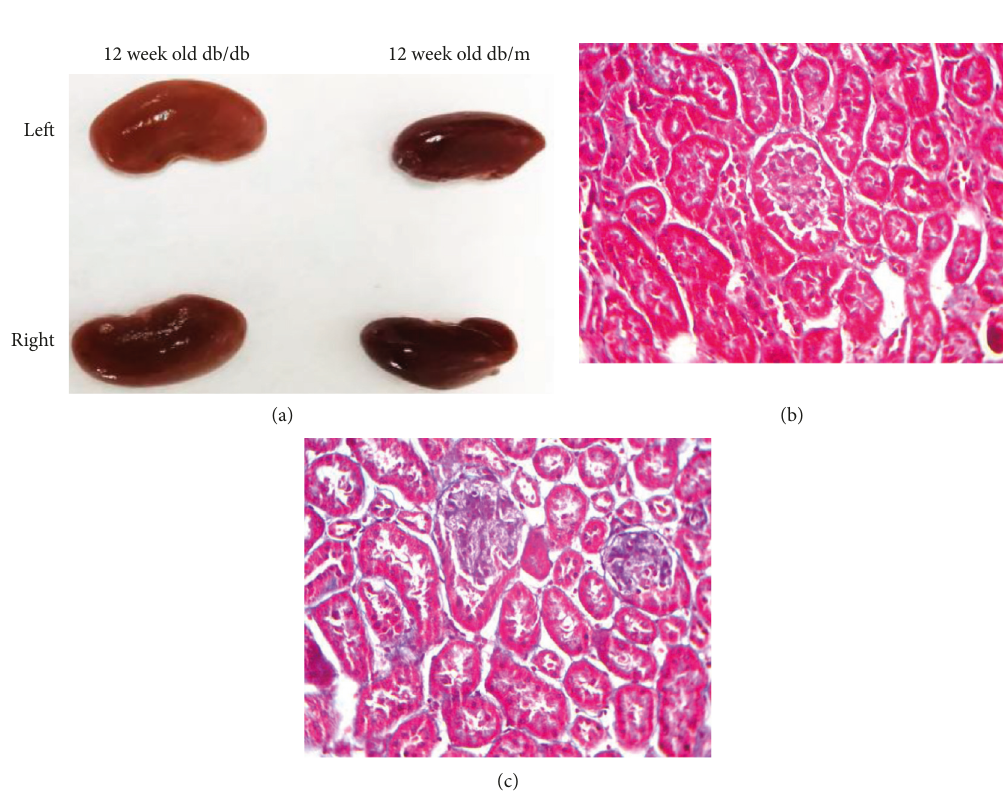
Figure 3: Observation of the shape of 12-week db/db and db/m control mice (a), renal pathological sectioning of db/m control mice (b), and renal pathological sectioning of 12-week db/db mice (c) (Masson, ×